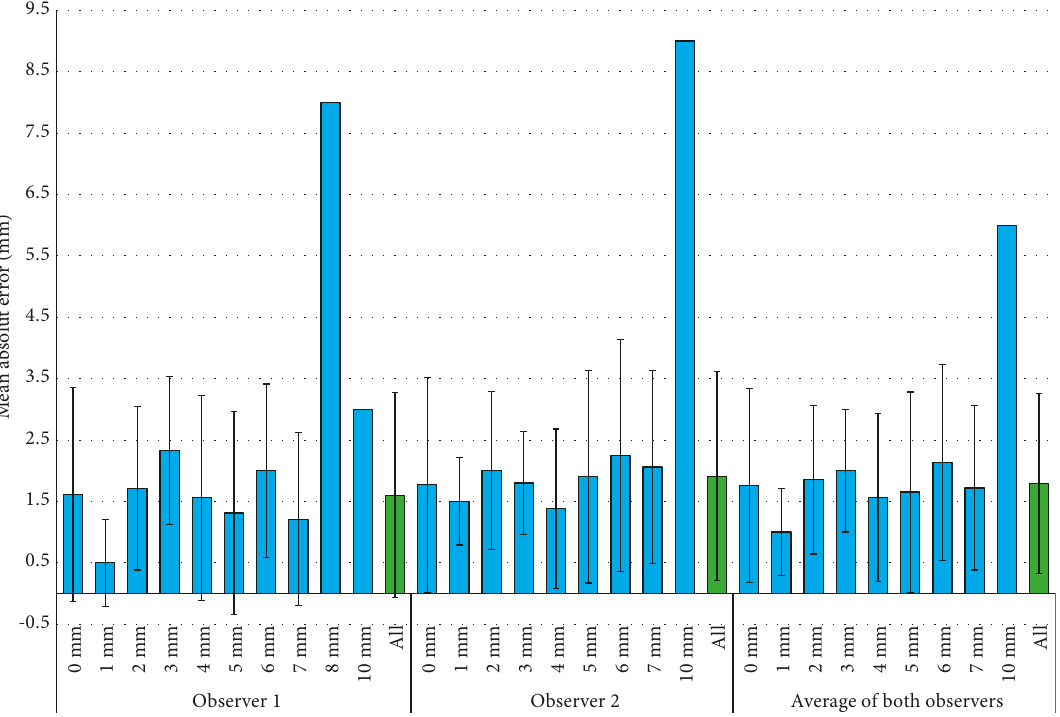
Figure 2: Mean (SD) of the directionless absolute error of resorption estimates (mm) in the case of each of the actual resorption extents